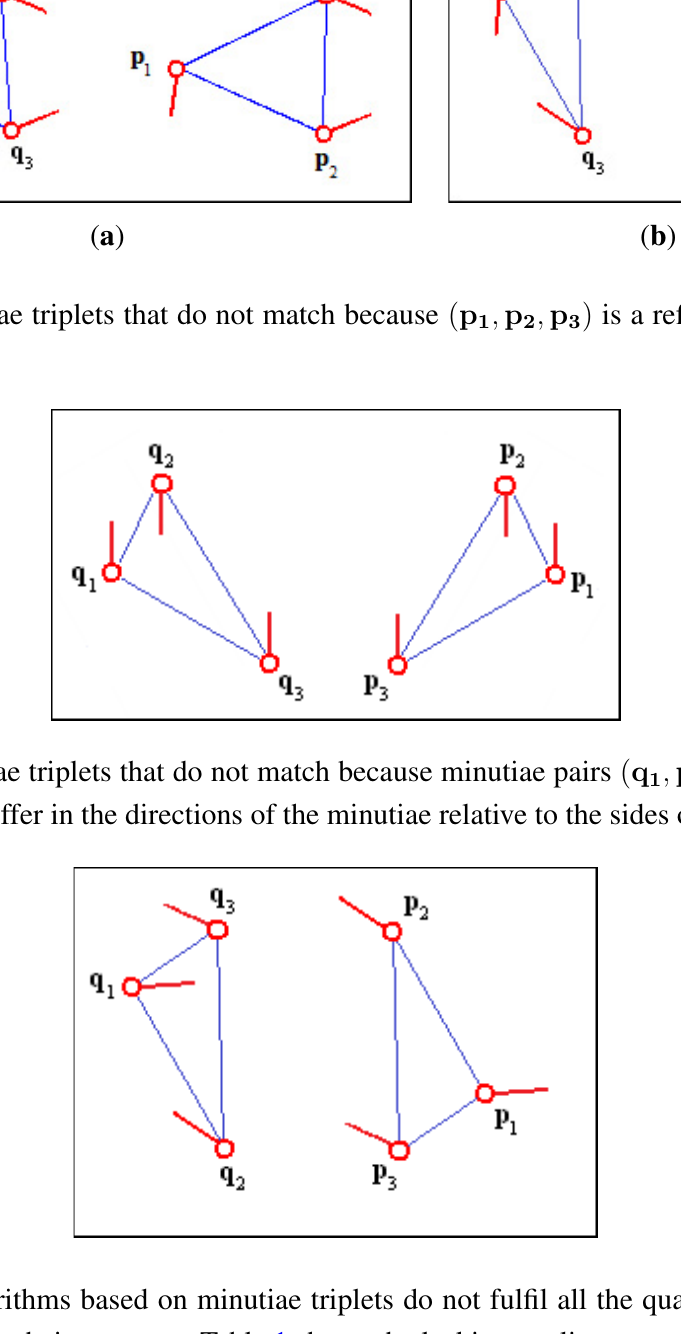
Figure 1. Similar minutiae triplets that were not classified as true matching by some algorithms because in image ( a ) the features are arranged according to the length of the sides, in image ( b ) the algorithms try to match the main minutia q main minutia p (right triplet). 1